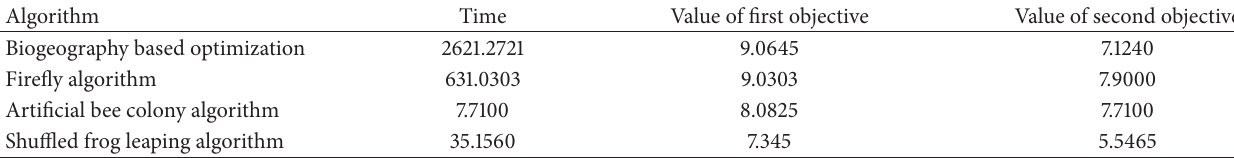
Table 6: The criteria for the result in metaheuristic algorithm used in the present study.